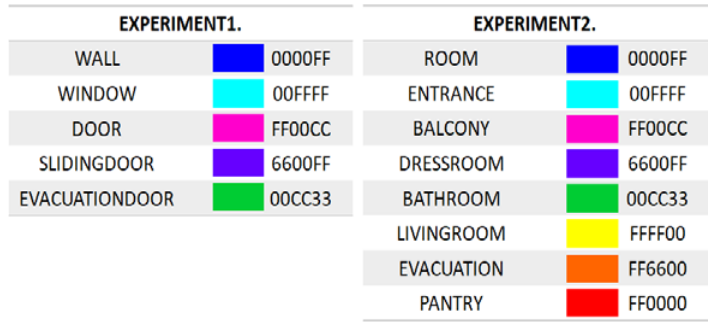
Figure 7. Indexing of drawing elements and space usage.